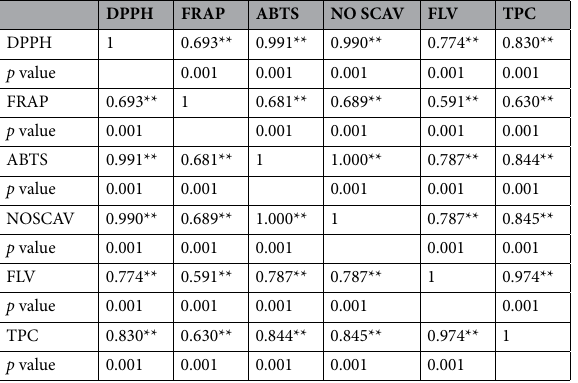
Table 3. Correlation matrix between antioxidants based on the solvent extracts reactions at p < 0.01 level **Correlation is significant at the 0.01